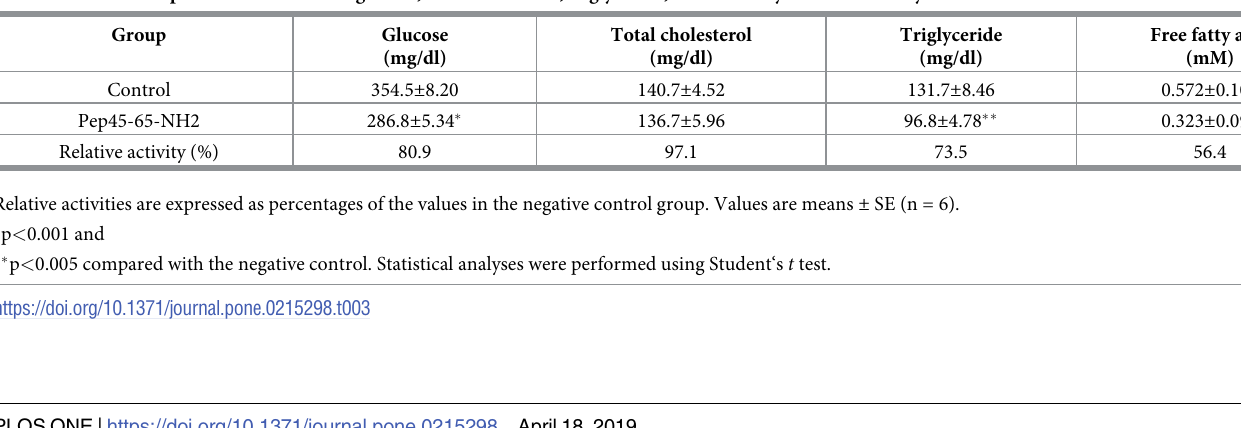
Table 3. Effects of Pep45-65-NH2 on blood glucose, total cholesterol, triglyceride, and free fatty acid level on day 14. Group